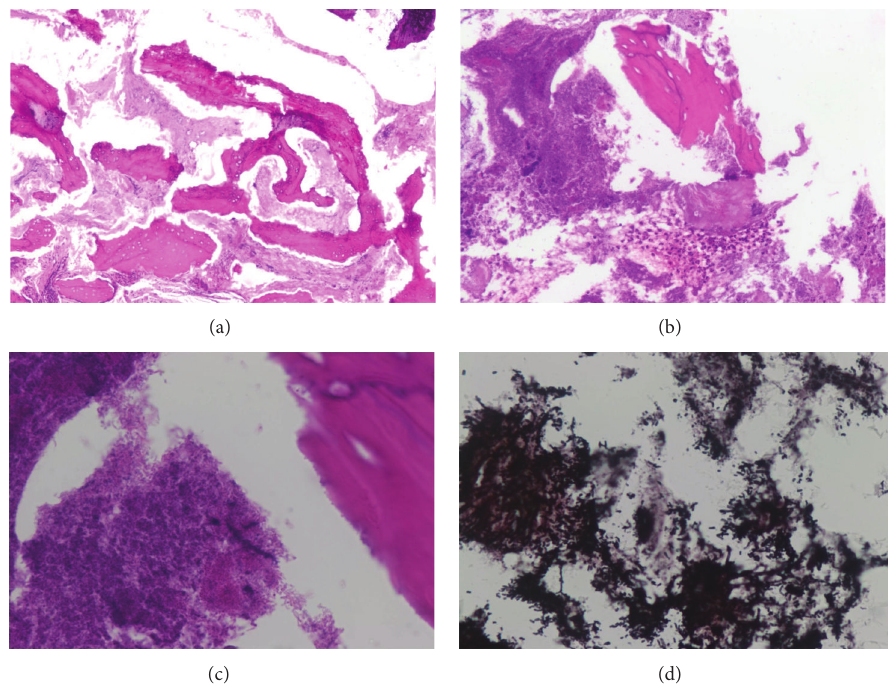
Figure 1: (a) H&E × 40. Overview: necrotic bone medullary spaces filled with hyphae. (b) H&E × 100 necrotic bone, hyphae, and altered Polymorphs. (c) H&E × 400. Detail: hyphae, and spores in medullary spaces. (d) Groccott × 400. Hyphae and